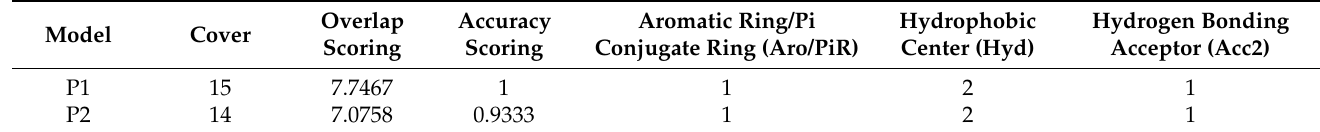
Table 1. Properties of two 4-scoring pharmacophore models.